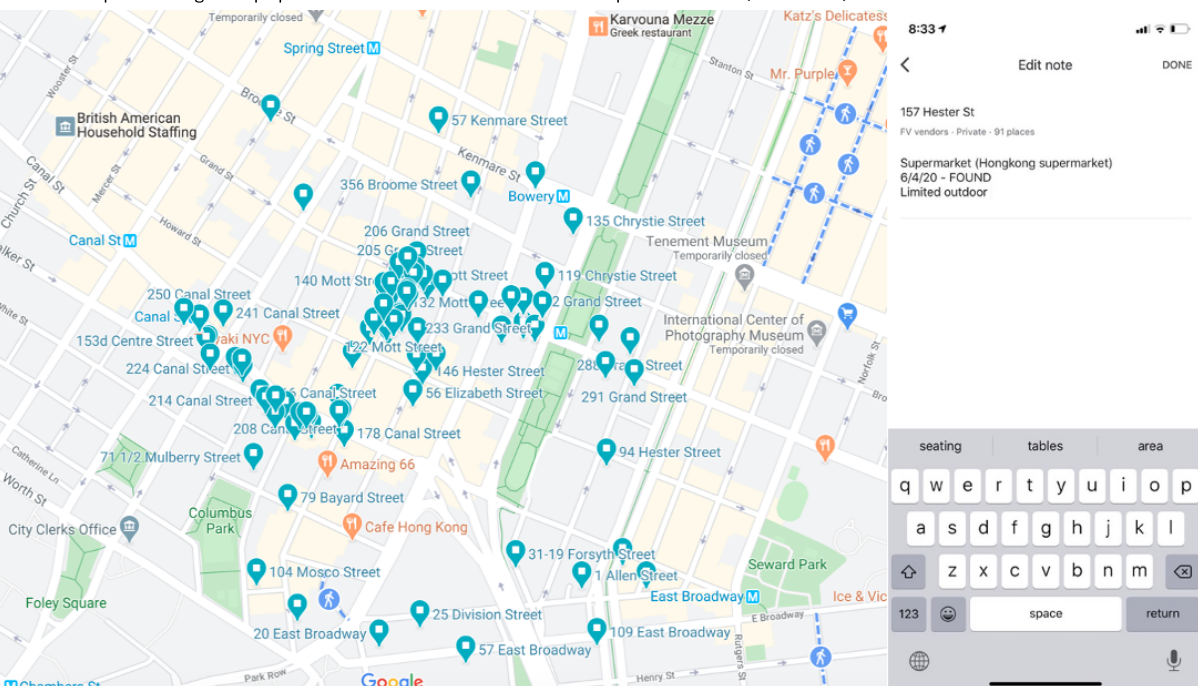
Figure 2. Example of Google Maps pins and the "notes" feature used for in-person checks